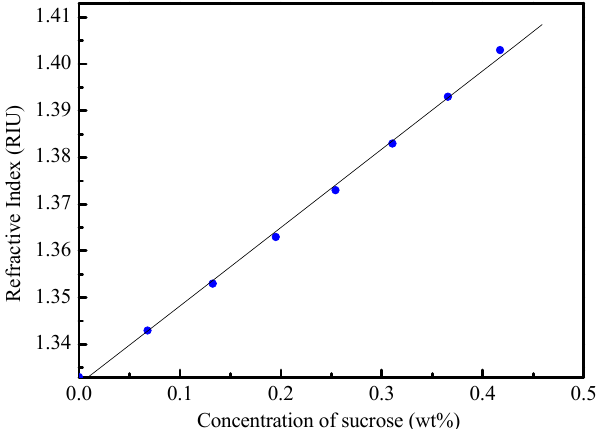
Figure 9 . Refractive index of the sucrose solution at different